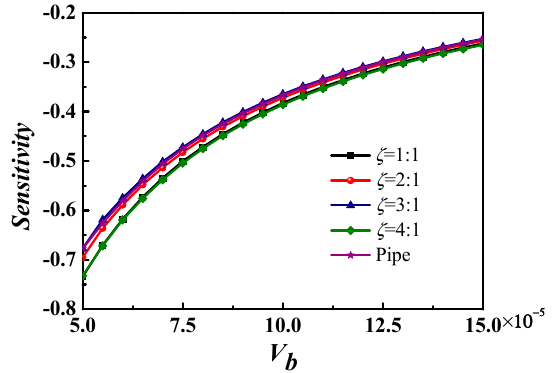
Figure 10. Sensitivity of the Vb number to the Nu number with various cross-sections.